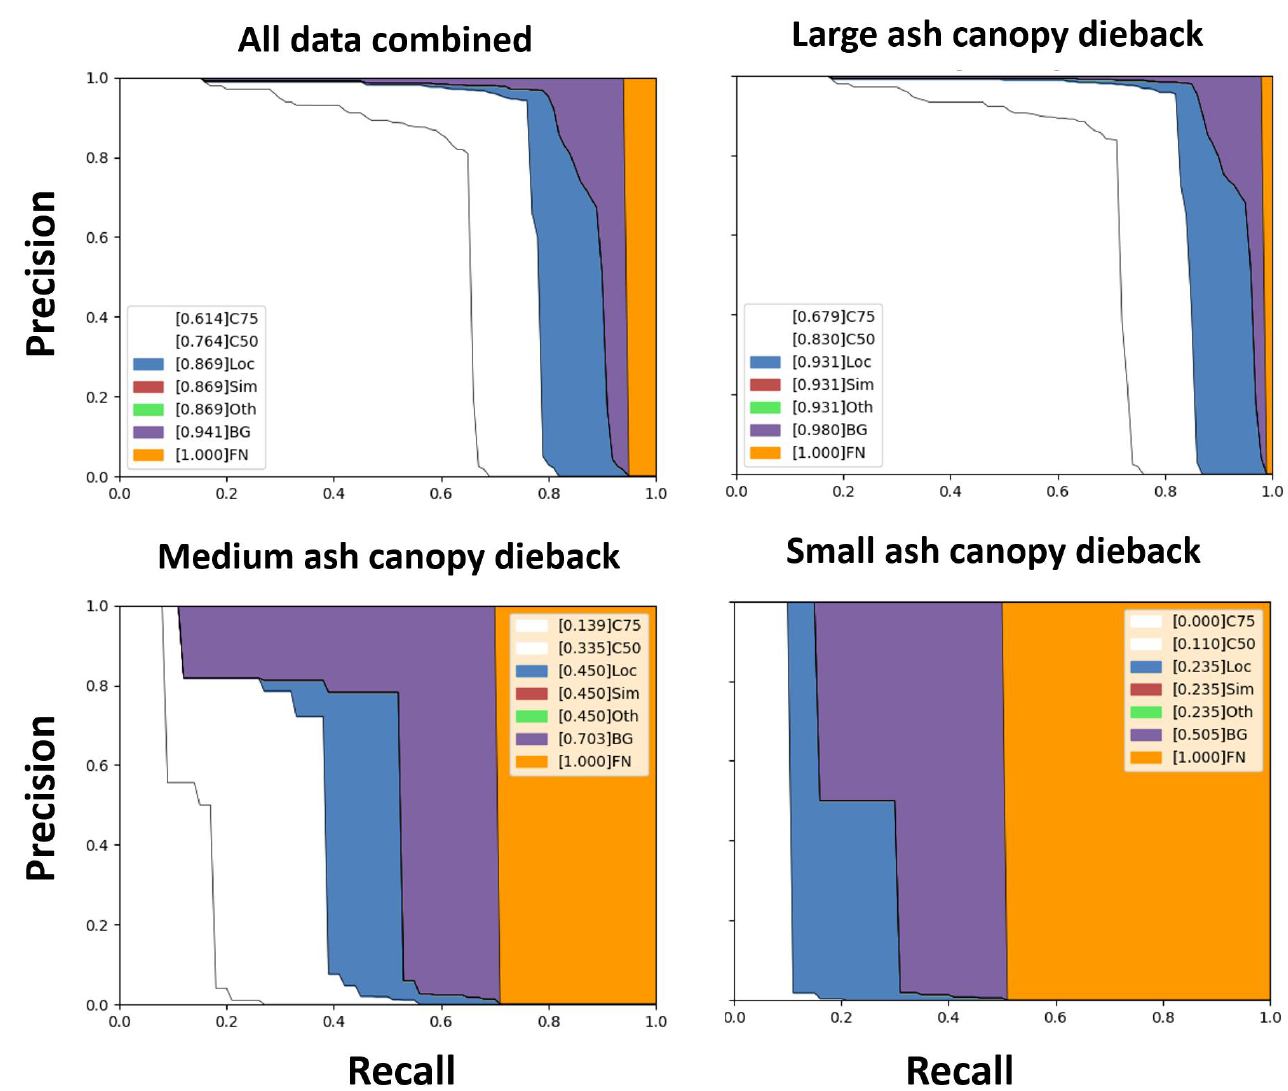
Figure 2. Precision – Recall (P – R) curves for ash trees showing different sizes (large, medium, and small) of ash canopy dieback. C75, IoU = 0.75; C50, IoU = 0.5; Loc, Localization; Sim, Similar objects; Oth, Other; BG, background; FN, false negative. The sizes of the canopy dieback were categorized based on pixel size: small (area < 32 2 pixels), medium (32 2 pixels < area < 96 2 pixels), and large (area > 96 2 pixels).